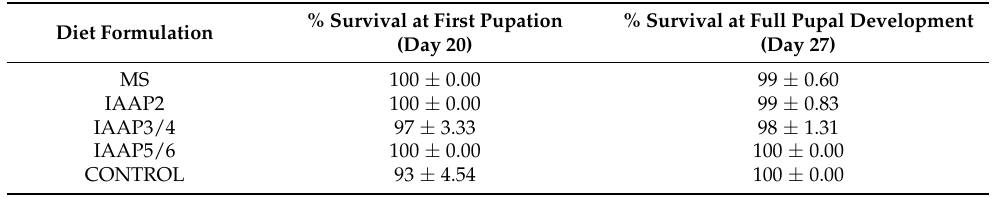
Table 3. Mean ( ± SE) survival of Eldana saccharina life stages reared on the MS, IAAP2, IAAP3/4, IAAP5/6 and control diets from inoculation of neonates to first pupation ( n = 15) on day 20 and full pupal production at harvest ( n = 85) (day